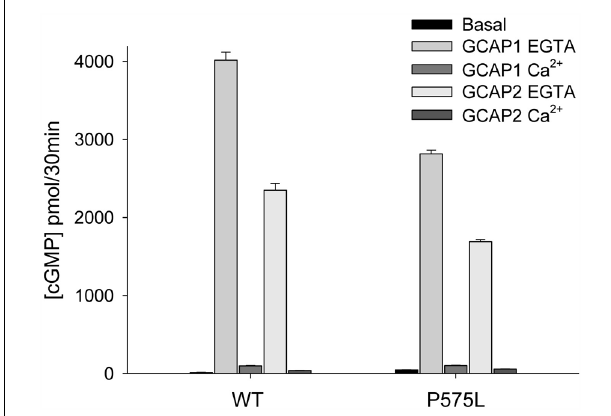
FIGURE 3 | Guanylate cyclase activities ofWT and the P575L mutant. Ca 2 + -bound and Ca 2 + -free (EGTA) GCAP1 or GCAP2 were added to HEK293 cell membranes expressing human ROS-GC1 (inset) yielding a final concentration of 10 μ M. Ca 2 + was either at 33 μ M or < 10 nM (EGTA). Assay incubations were performed with equal amounts ofWT and mutant guanylate cyclase in membranes, which was verified by western blotting (see Figure 2B ). Some error bars are not visible due to the scaling of the figure. Differences between data sets were highly significant yielding *** P ≤ 0.001, except for P575L; when its basal activity was compared with the activity in the presence of Ca 2 + -bound GCAP2, it resulted in** P ≤ 0.01.